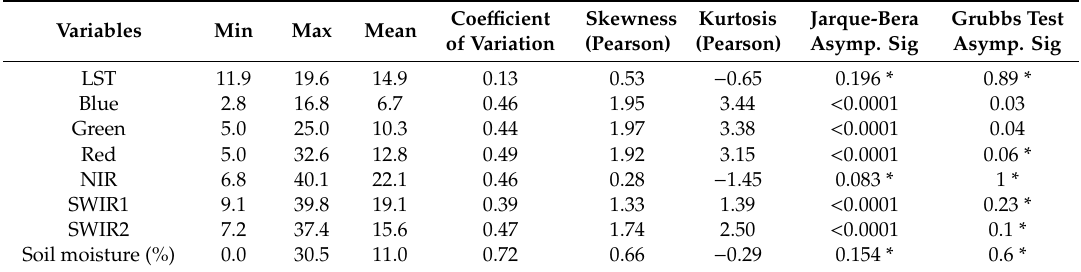
Table 2. Descriptive statistics of variables and statistical tests used for SMC